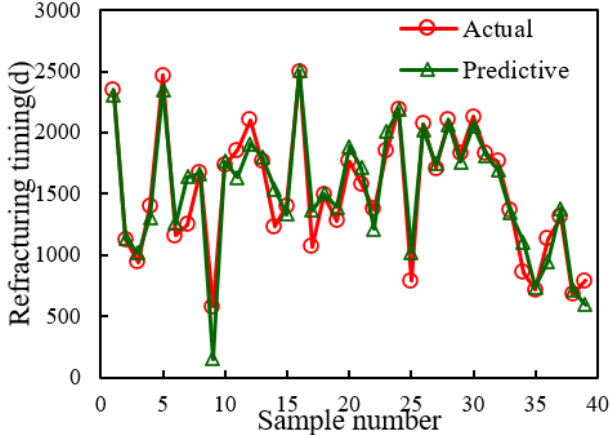
Figure 11. Comparison curve of true value and predicted value of some test samples.